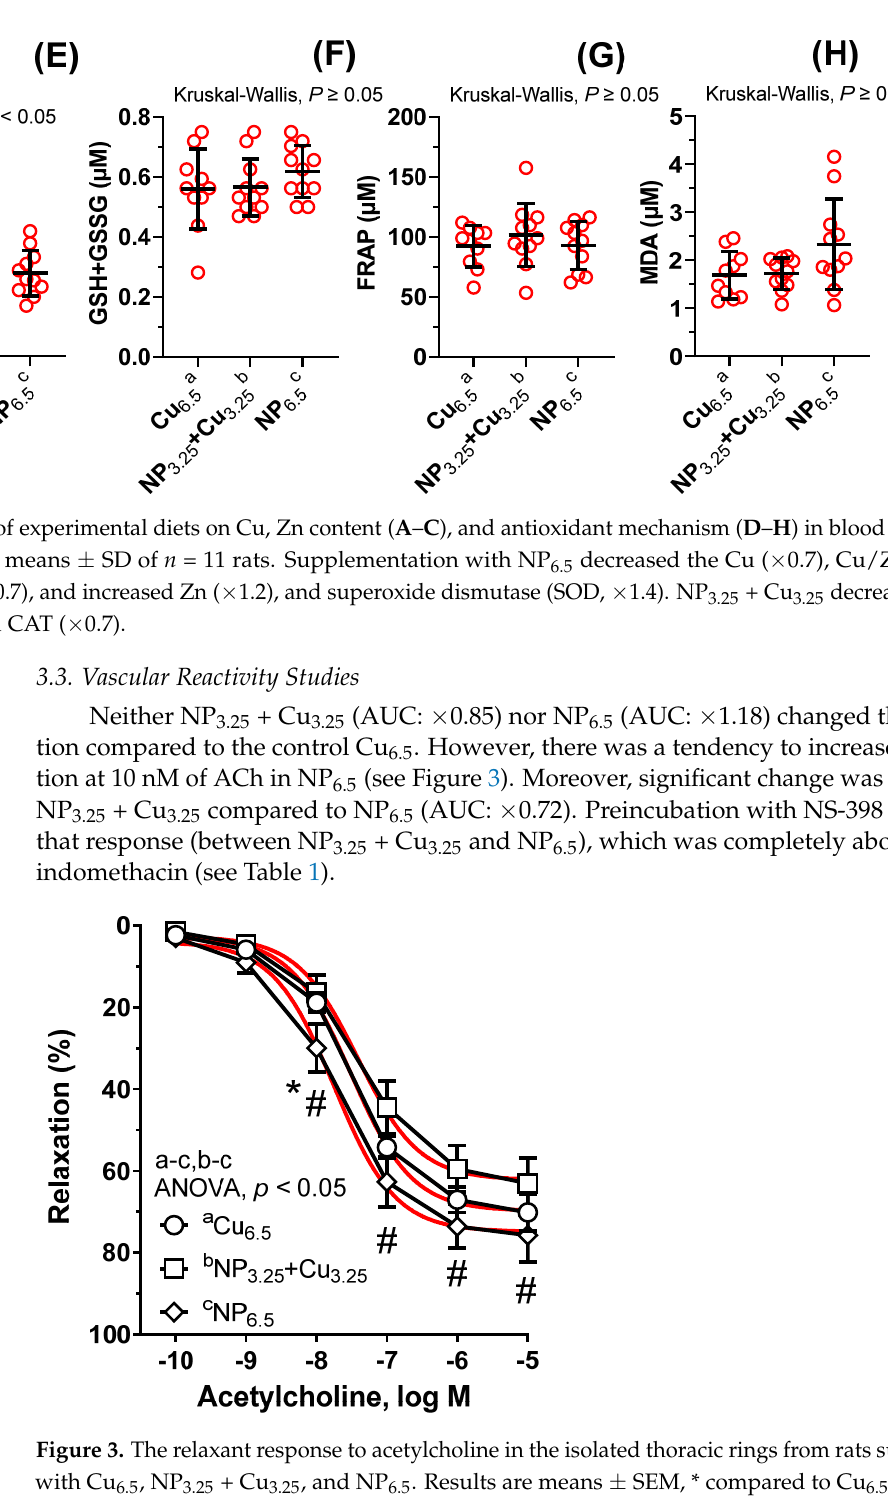
Figure 4. The influence of 1400W on the relaxant response to acetylcholine. Aortic rings from rats supplemented with Cu 6.5 ( A ), NP 3.25 + Cu 3.25 ( B ), and NP 6.5 ( C ) were pre-incubated with the inducible nitric oxide synthase inhibitor (1400 W, 30 min, 1 µM). Results are means ± SEM, p > 0.05 of n = 5 rats; two-way ANOVA/Sidak’s. Preincubation with the selective iNOS inhibitor did not modify the vasodilation. Neither the selective COX-2 inhibitor (NS-398, 10 µM), nor the non-selective COX- 1/2 inhibitor (indomethacin, 10 µM) changed the acetylcholine-induced response in the following groups of rats: Cu 6.5 (AUC: ×1.09, and ×1.10, respectively, Figure 5A), and NP 3.25 + Cu 3.25 (AUC: ×0.90, and ×1.05, respectively, Figure 5B). However, a decreased response was observed in the NP 6.5 group (×0.84, and ×0.81, respectively, Figure 5C). There was no significant difference between NS-398- and indomethacin-induced response in NP 6.5 (AUC: ×1.04), opposite to some changes in NP 3.25 + Cu 3.25 (AUC: ×0.86).